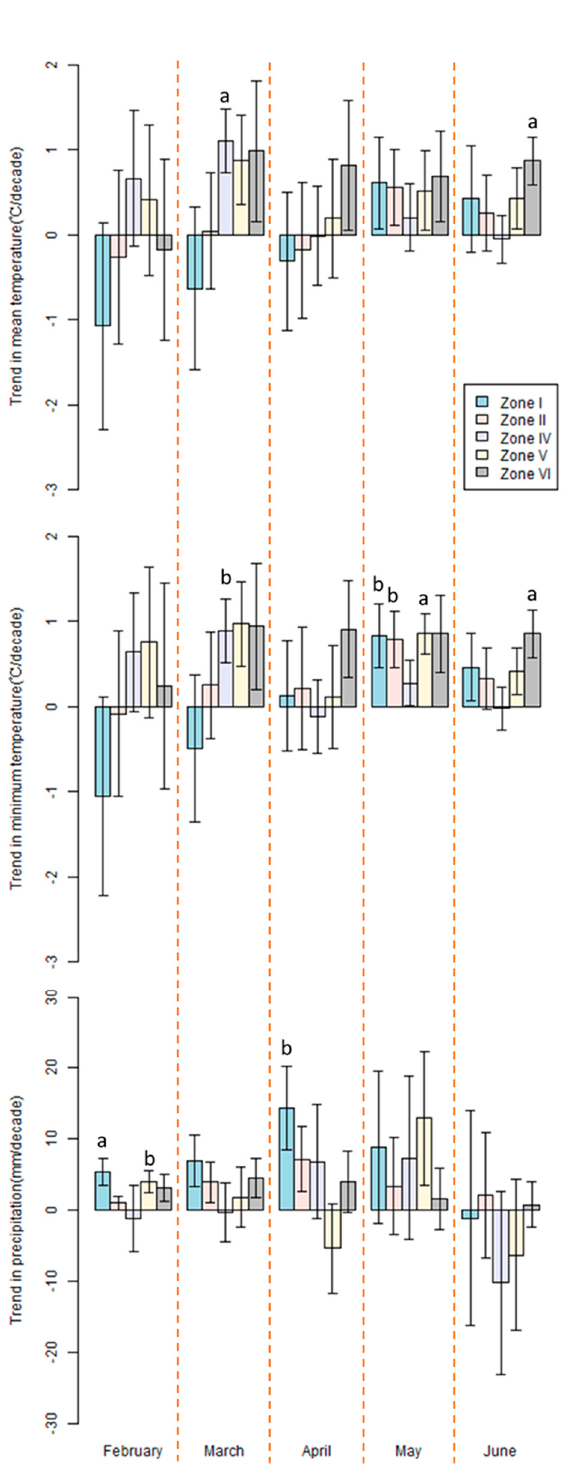
Figure 3. Trends in mean temperature (T), average minimum temperature (T min ) and precipitation during February to June of spring maize from 1992 to 2010 in each maize production zone. The error bar represents the standard error of the estimates. The trends with a mark ‘a’ are significant at 0.01 level, and with a mark ‘b’ are significant at 0.05 level.